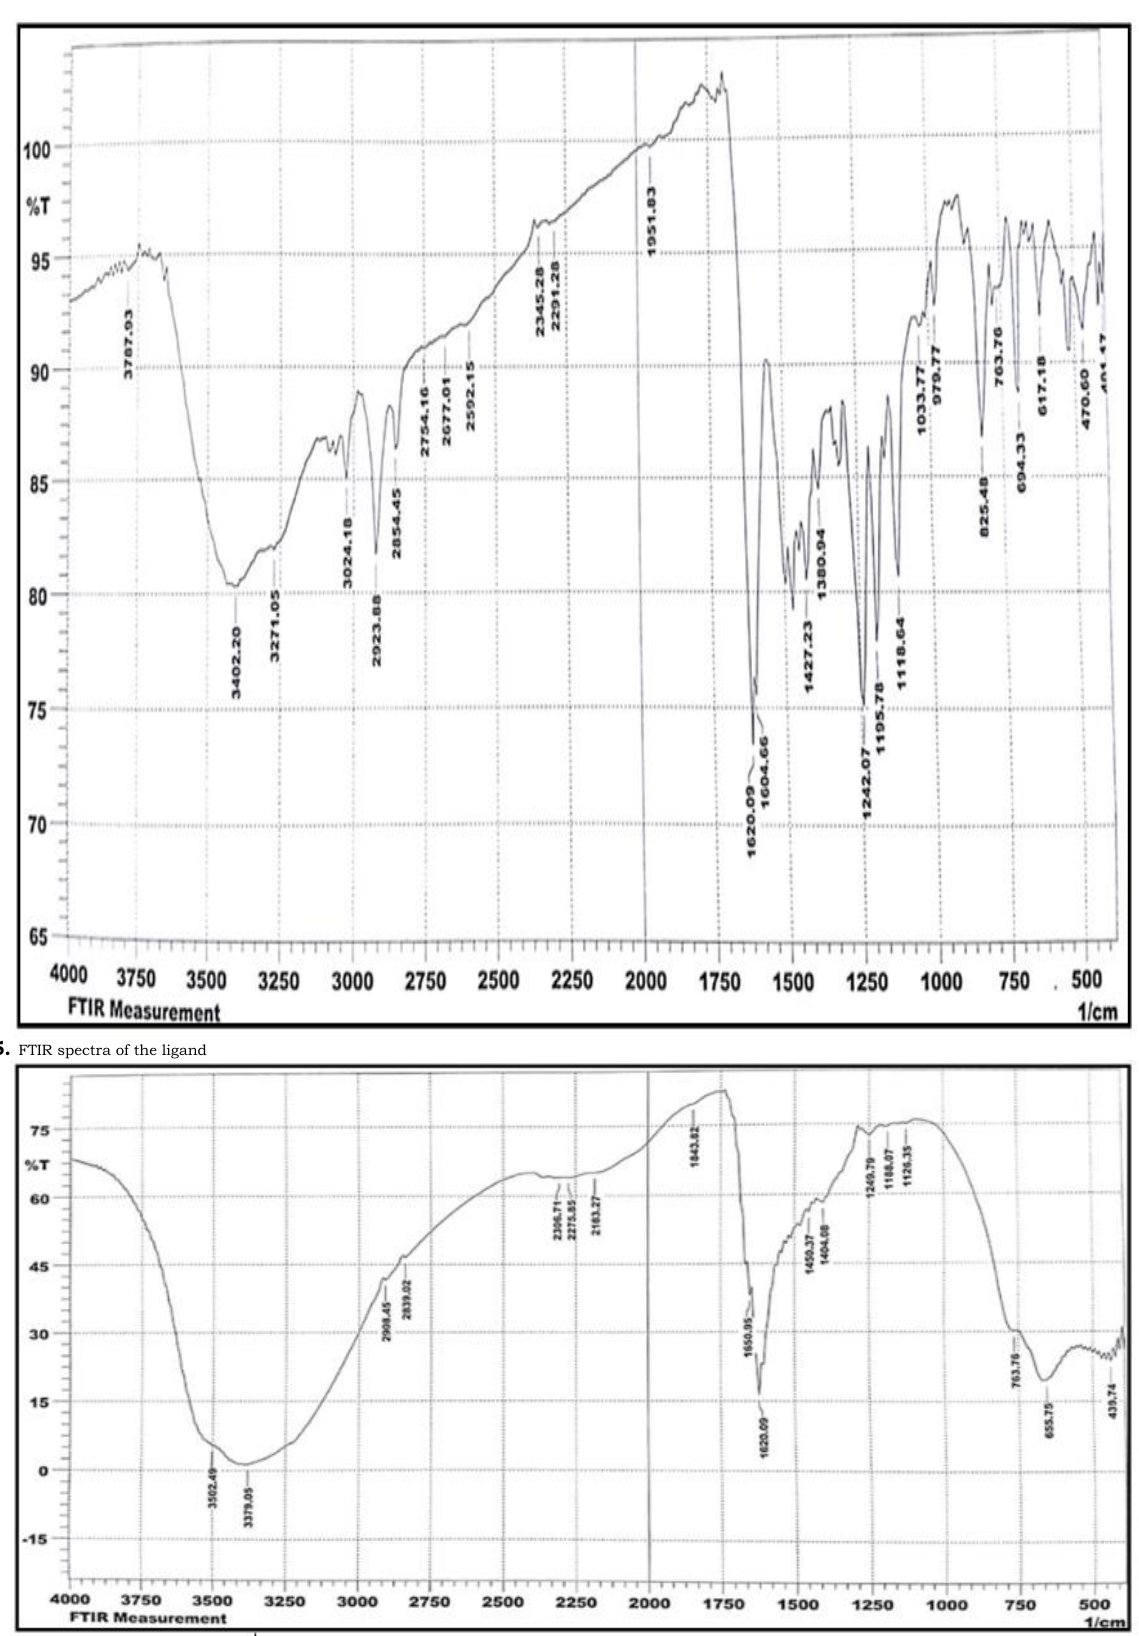
Fig. 5. FTIR spectra of the